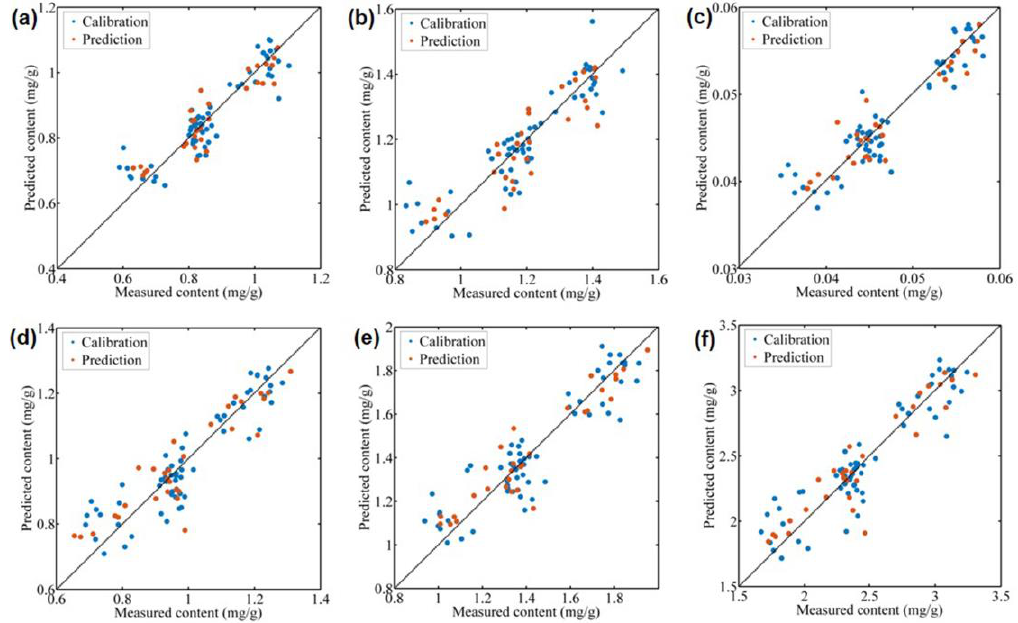
Figure 4. Optimal prediction models using CARS-PLS on spectral data for palmitic acid ( a ); total saturated fatty acids ( b ); oleic acid ( c ); linoleic acid ( d ); linolenic acid ( e ); and total unsaturated fatty acids ( f ).